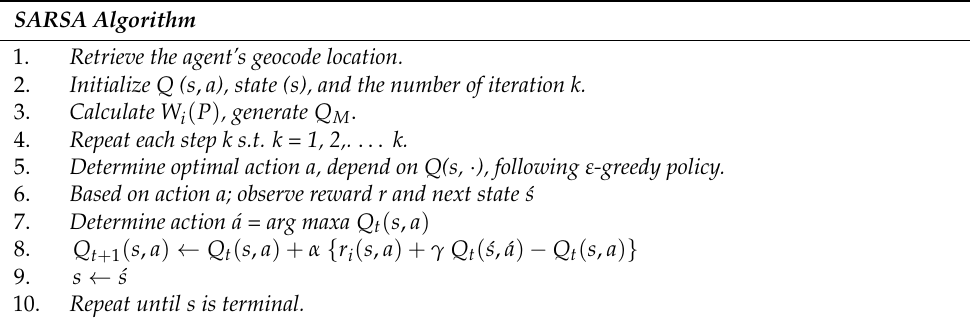
Table 1. Pseudo-code of the SARSA